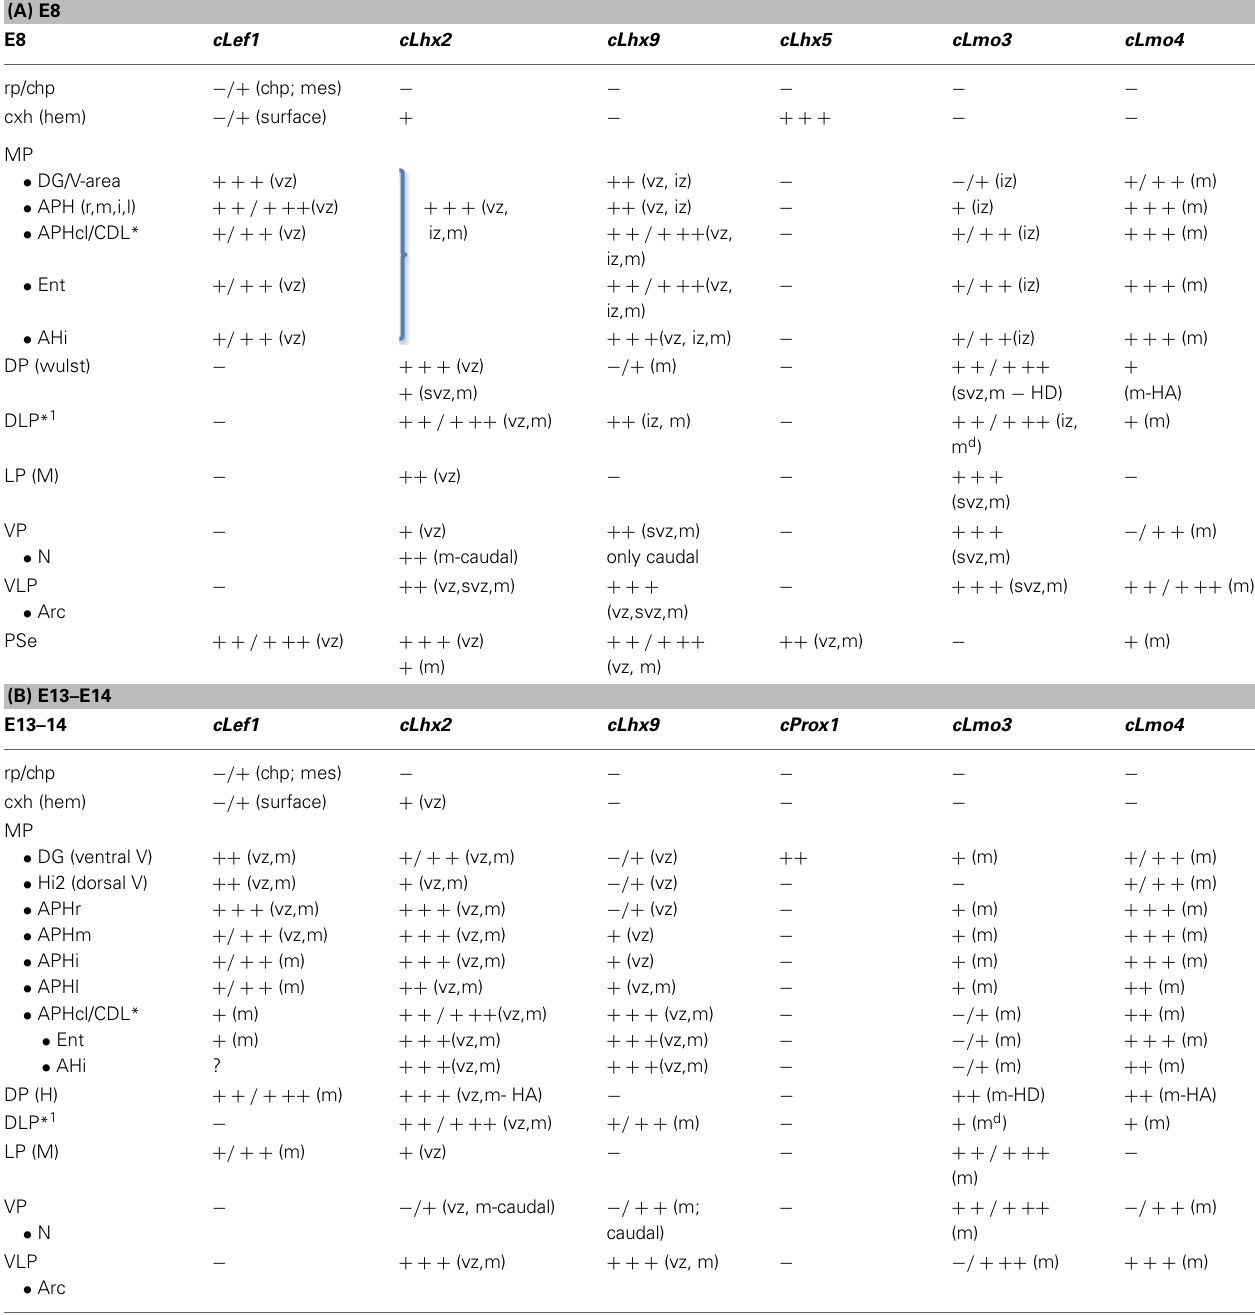
Table 2 | Combinatorial expression of Lef1 and other regulatory genes in the pallial progenitor zones and hippocampal complex primordia of developing